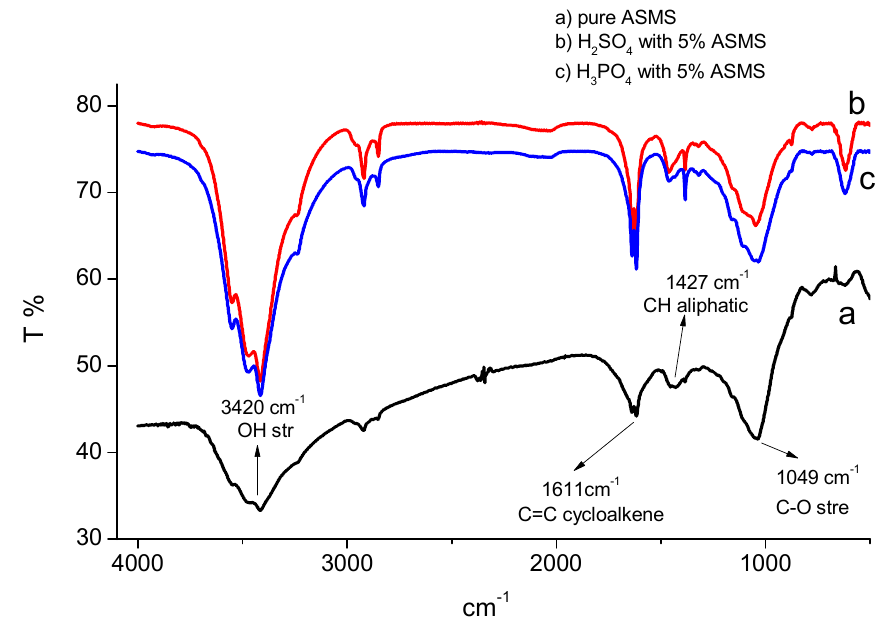
Figure 9. Fourier transform infrared spectroscopy (FTIR) spectra of di ff erent solutions ( a ) pure ASMS, Figure 9 . Fourier transform infrared spectroscopy (FTIR) spectra of different solutions a ) pure ASMS, ( b ) H 2 SO 4 with 5% ASMS and ( c ) H 3 PO 4 with 5% b ) H2SO4 with 5% ASMS and c) H3PO4 with 5% ASMS.